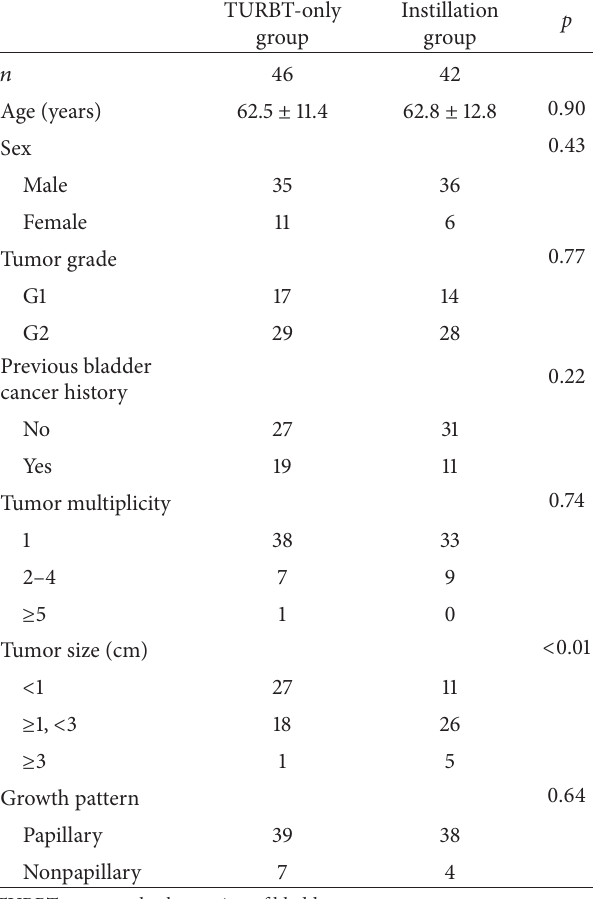
Table 1: Subject characteristics.